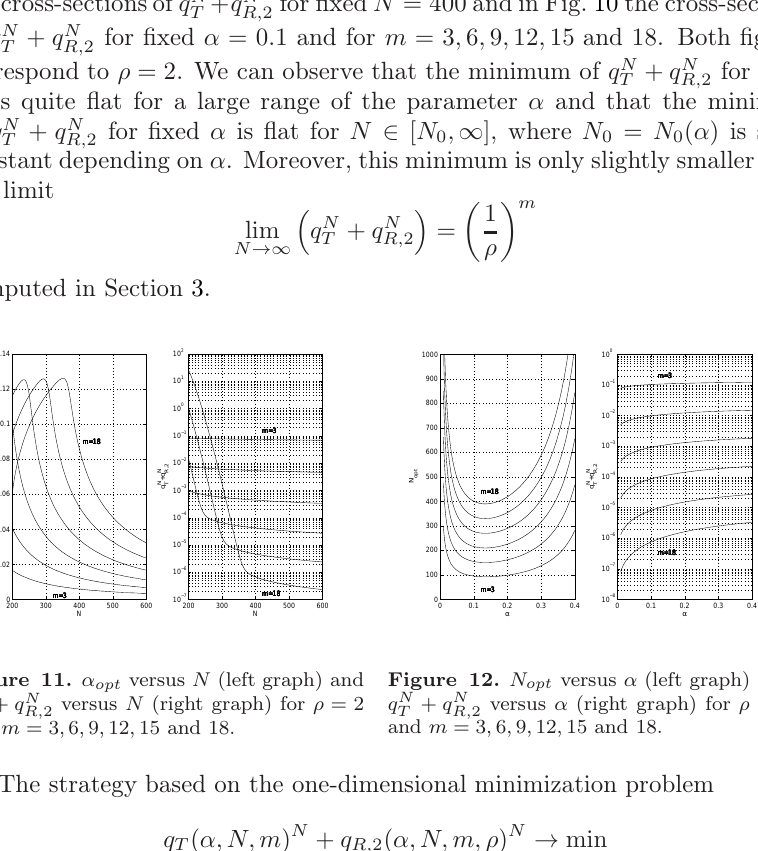
Figure 10. Cross-sections of q T ( α,N,m ) N + q R, 2 ( α,N,m,ρ ) N for α = 0 . 1 , ρ = 2 and m = 3 , 6 , 9 , 12 , 15 and 18 .